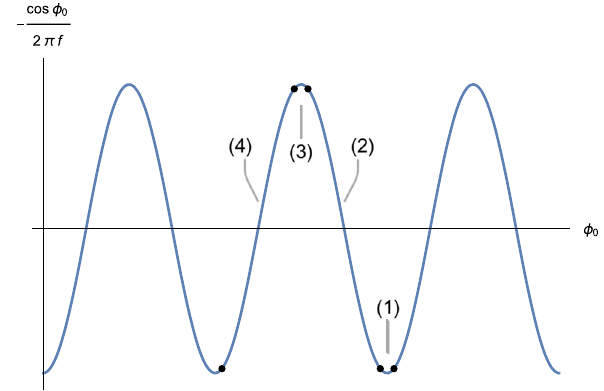
Fig. 1 The periodical term in the equation of motion of ϕ k . φ 0 decreases as time proceeds, and the evolution of ϕ k in each period is analysed separately for the phases (1), (2), (3), (4) the parameter values μ ∼ 0 . 1, (cid:5) ∼ 0 . 01, f ∼ 0 . 001, all in Planck